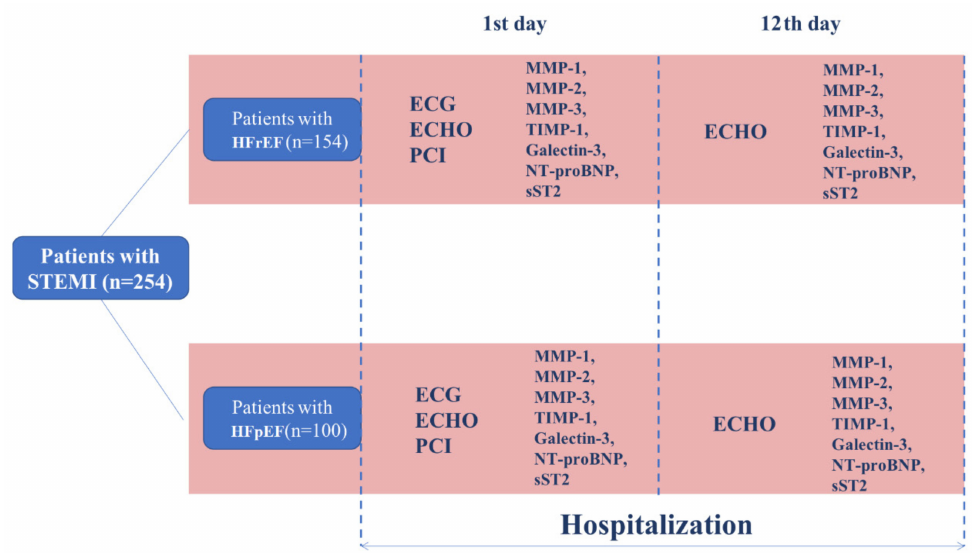
Figure 1. Study design. STEMI—ST-segment elevation myocardial infarction, HFpEF—STEMI with preserved ejection fraction, HFrEF—STEMI with reduced ejection fraction, ECG—electrocardiography, ECHO—echocardiography, PCI—percutaneous coronary intervention, MMP—matrix